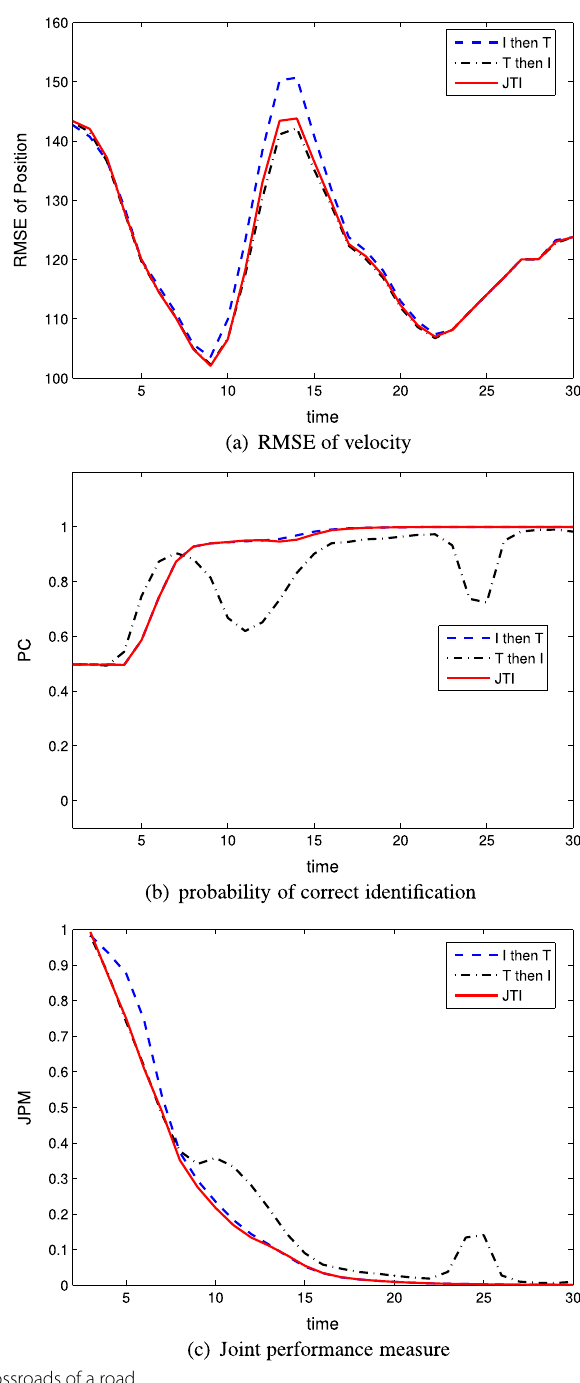
Fig. 5 JTI at a crossroads of a